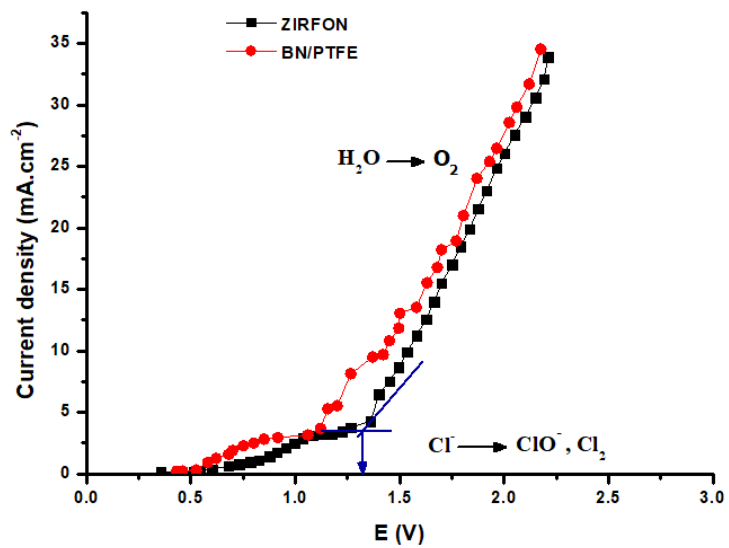
Figure 4. Current–voltage curves for Zirfon ® and BN/PTFE membranes obtained with the used cell and saturated NaCl solution.